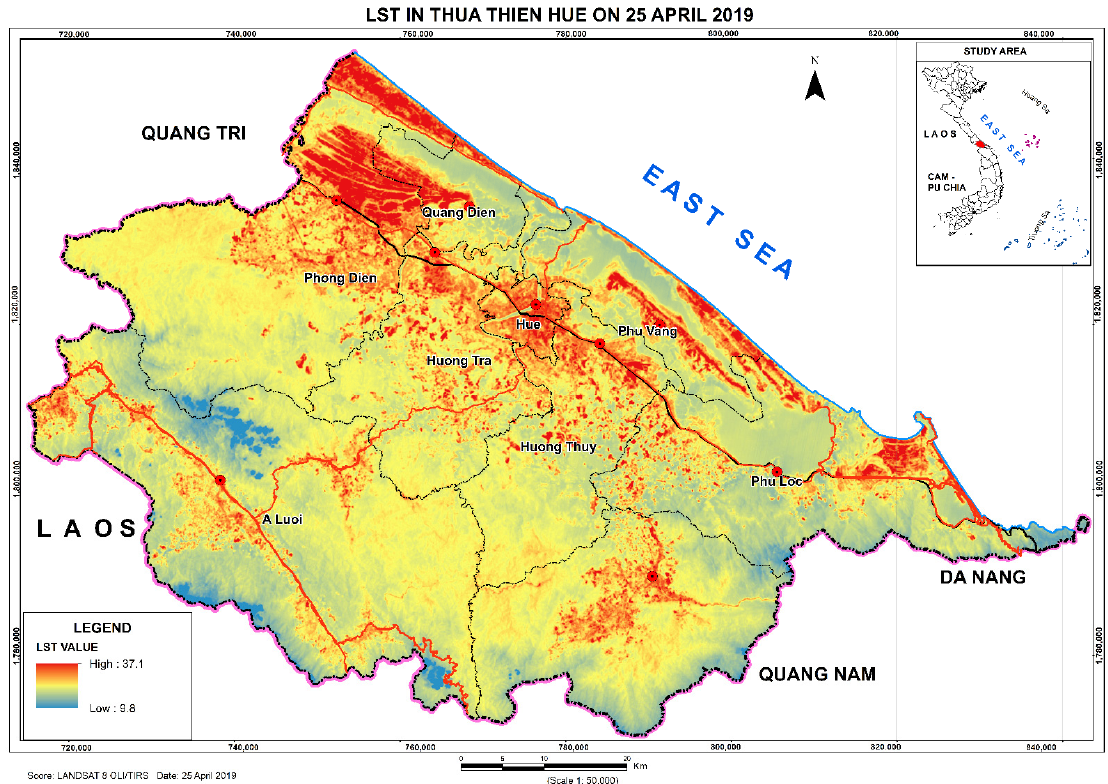
Figure 7. LST of Thua Thien Hue on 25 April 2019.